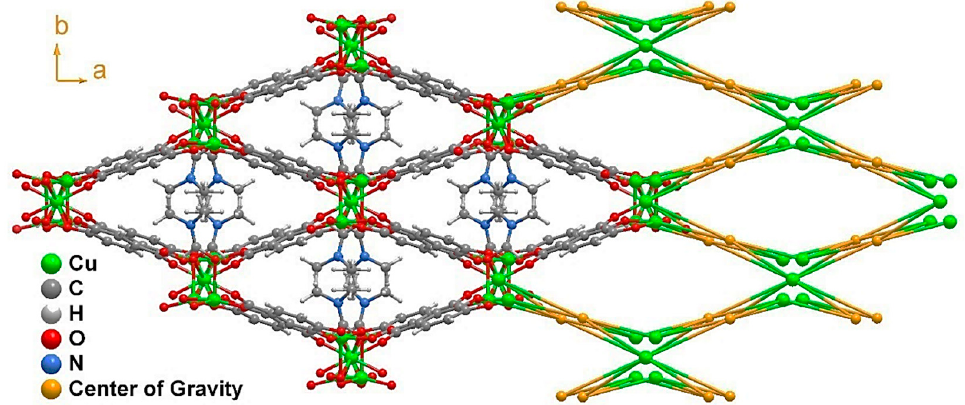
Figure 3. Structural packing of [Cu 3 L 2 (DMF) 2 ] n ( 1 ) as viewed in the (001) direction, alongside its topological view. The disorder present in the DMF molecule was removed for clarity.